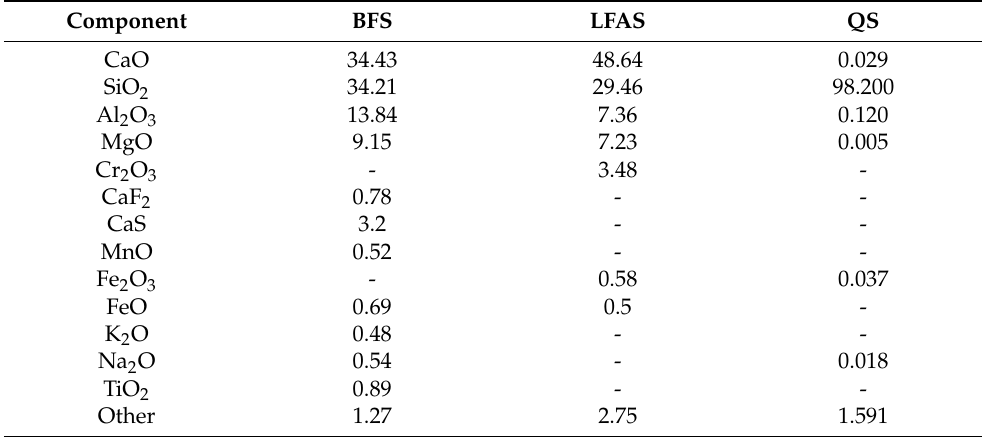
Table 1. Main chemical components of raw materials (mass fraction, %). Component